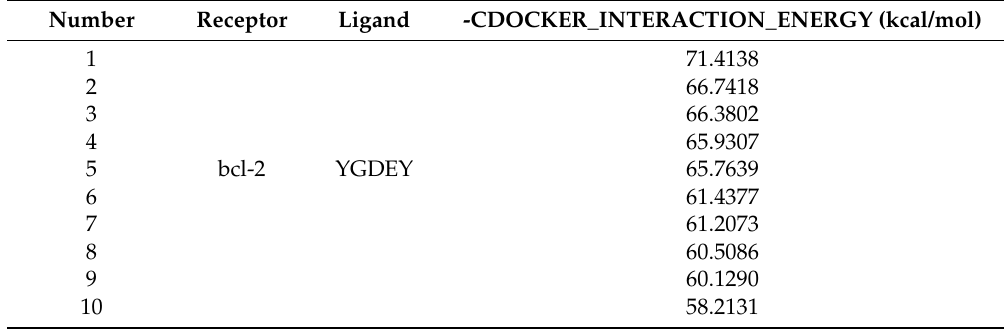
Table 1. Methods of docking between bcl-2 and